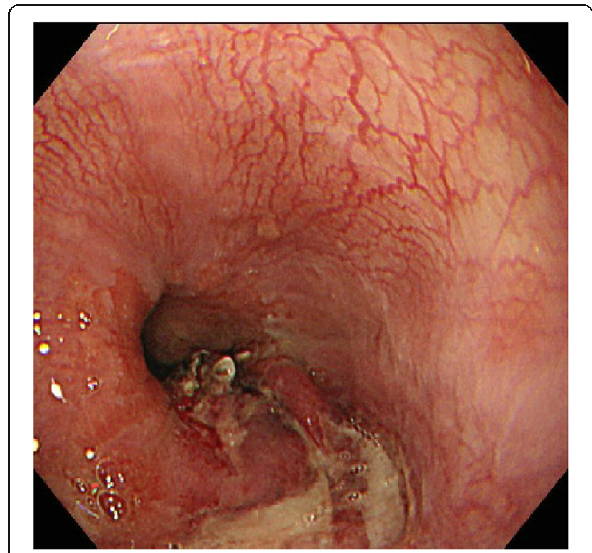
Fig. 3 Upper gastrointestinal endoscopy image 7 days after surgery. The esophageal submucosal had almost disappeared, and the slough had adhered to the mucosal laceration at the esophagogastric